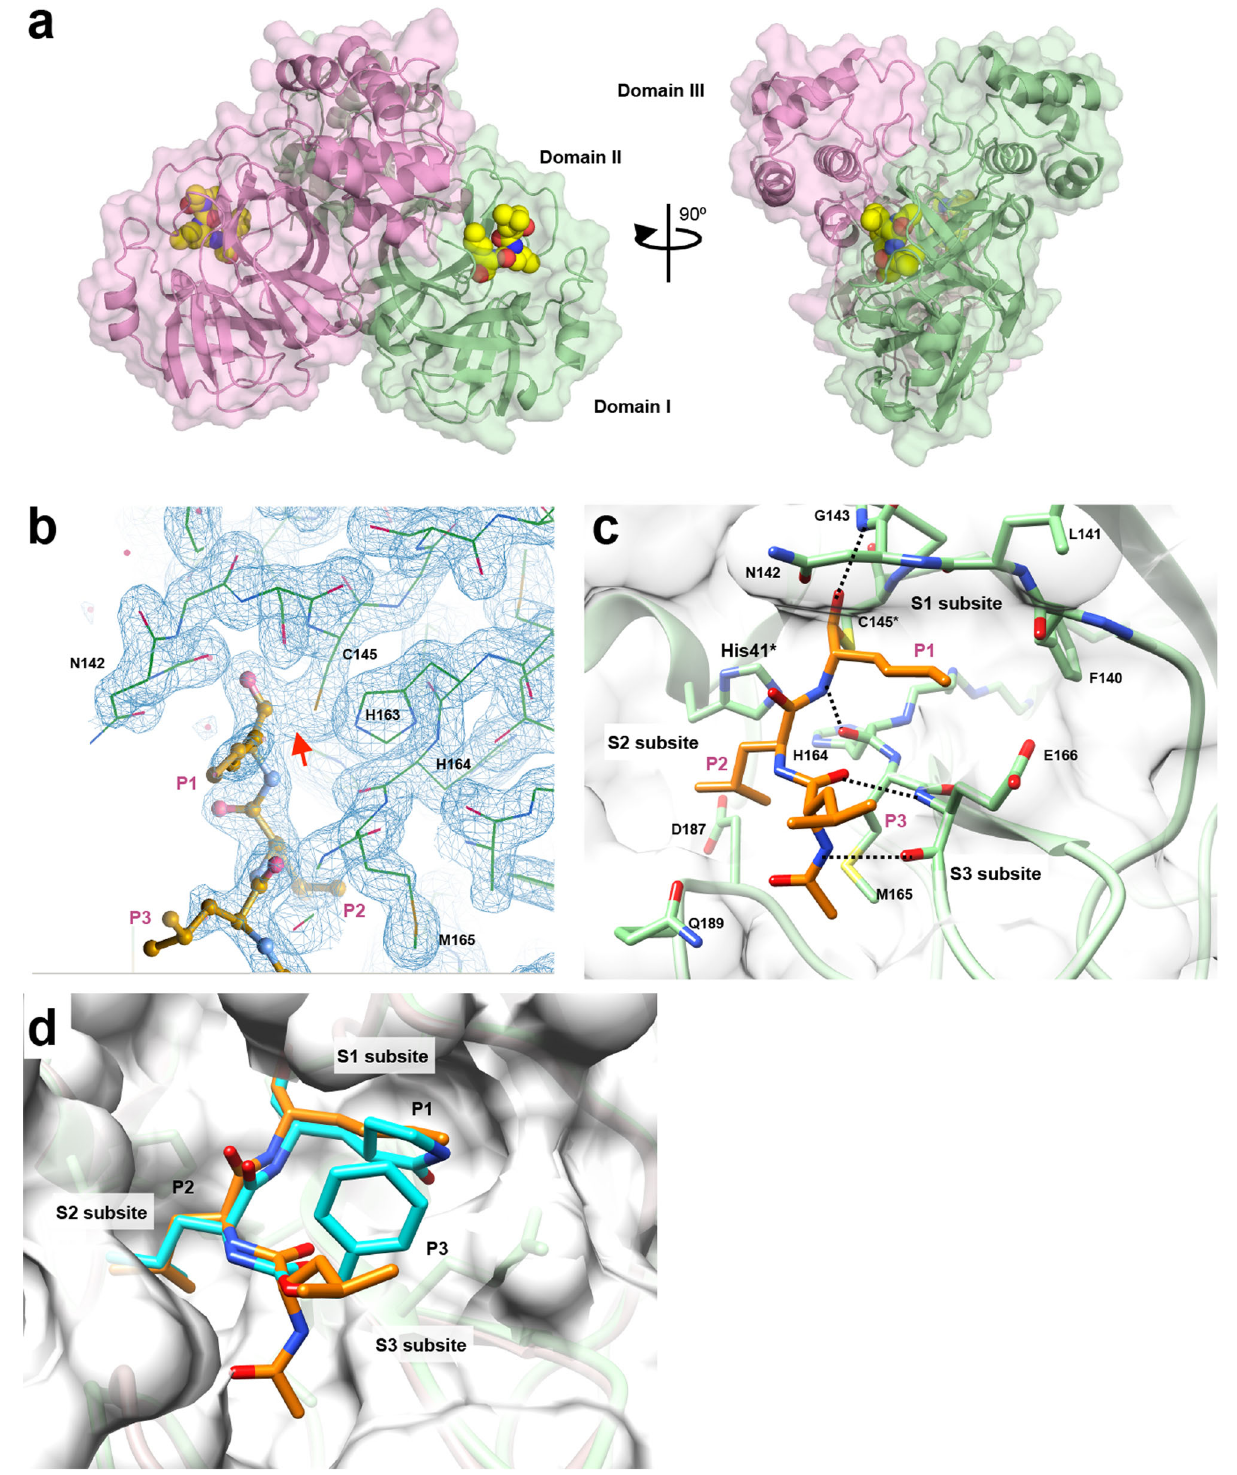
Fig. 9 Structural basis for the Mpro inhibition. a Crystal structure of the Mpro and MG-101 complex. Mpro dimer is depicted as a cartoon model with a transparent surface and each protomer is colored green and pink. MG-101 is shown as CPK representation. b Electron density map ( 2Fo – Fc , blue mesh) of MG-101 bound at the active site of Mpro. The inhibitor and Mpro are depicted as ball-and-stick and wire models, respectively. A thiohemiacetal covalent between the inhibitor and C145 residue of Mpro is indicated by a red arrow. c Interactions between the inhibitor and active site of Mpro. The binding of MG-101 is stabilized by H-bonds (black dot lines) with Gly143, Cys145, His164, and Glu166. d Comparison of the binding of MG-101 (orange) and GC373 (cyan) at the active site of Mpro. S1 – S3 subsites of Mpro and P1 – P3 of inhibitors are